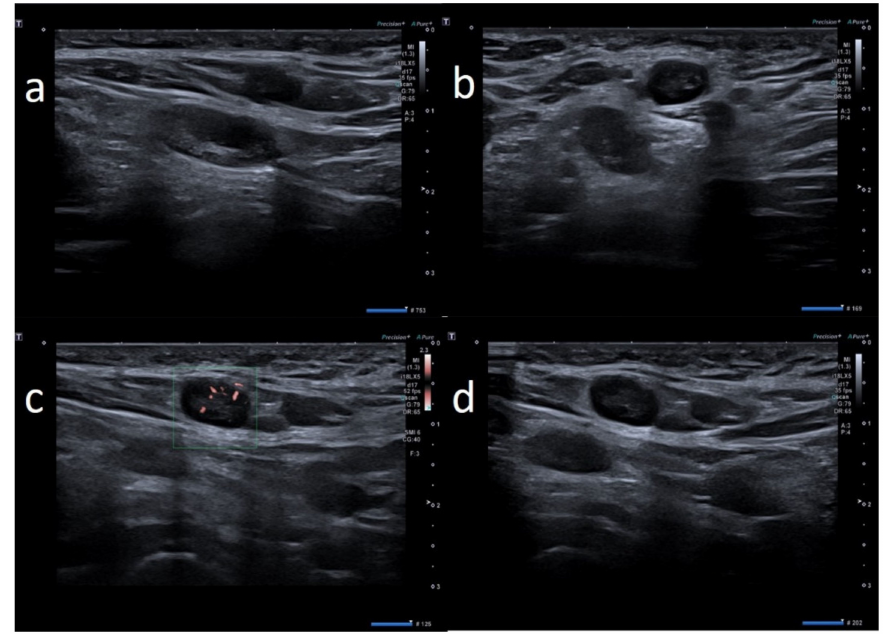
Figure 6. 25-year-old female with unilateral left axillary adenopathy noted 5 days after receiving the first dose of the Pfizer-BioNTech COVID-19 vaccine in her left deltoid muscle. ( a , b ) B-mode sonogram image shows ovular lymph nodes with asymmetric cortex and dislocate hilum. ( c ) After 2 months, SMI image shows normal vascularization ( d ) and cortical thickening appears uniform with normal hilum